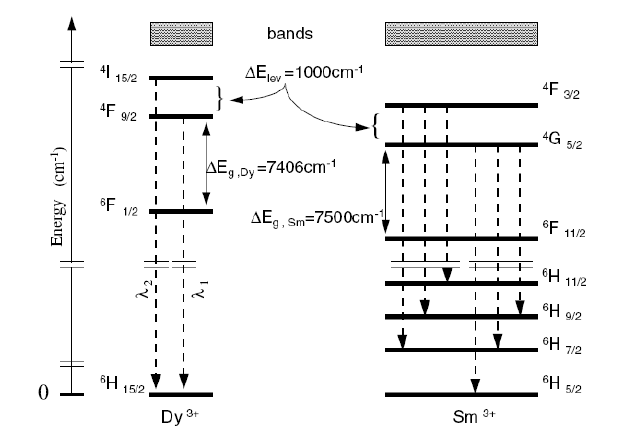
Figure 11. Emission spectra at different temperatures. Left: YAG:Dy [30]; Right: Y